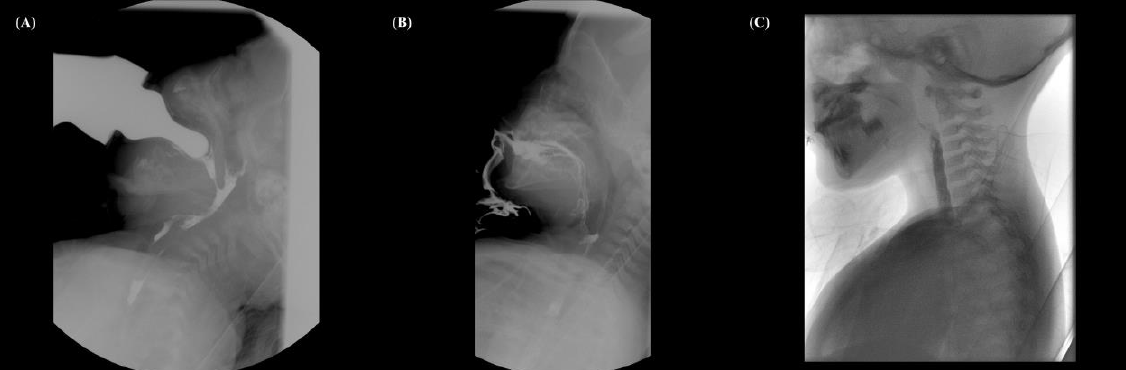
Figure 2. VFSS of patient 2. ( A ) VFSS on the 42nd day after birth with a bottle of milk (IDDSI level 0). The initiation of pharyngeal swallowing was severely delayed, the soft palate elevation was reduced, and repeated aspiration into the airway without a cough reflex (PAS 8) was observed. ( B ) VFSS at 10 months using pureed foods (IDDSI level 4). Food spilled beyond the chin due to poor lip closure, and minimal bolus preparation or transport occurred. Laryngeal elevation and epiglottic movement were partially improved so that there was no aspiration or penetration (PAS 0), with some pharyngeal residue. ( C ) VFSS at 2 years (35 months) using a scrambled egg (IDDSI level 5). Although she exhibited weak, slow, and prolonged mastication, she has demonstrated safe and efficient swallowing with a well-formed bolus.